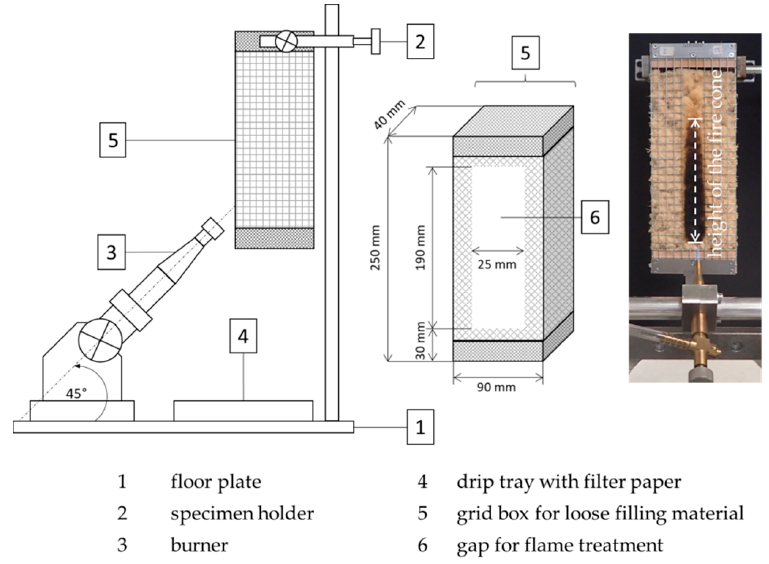
Figure 11. Schematic illustration of the fire test according to ISO 11925-2 and exemplary photo of a specimen after flaming [29].